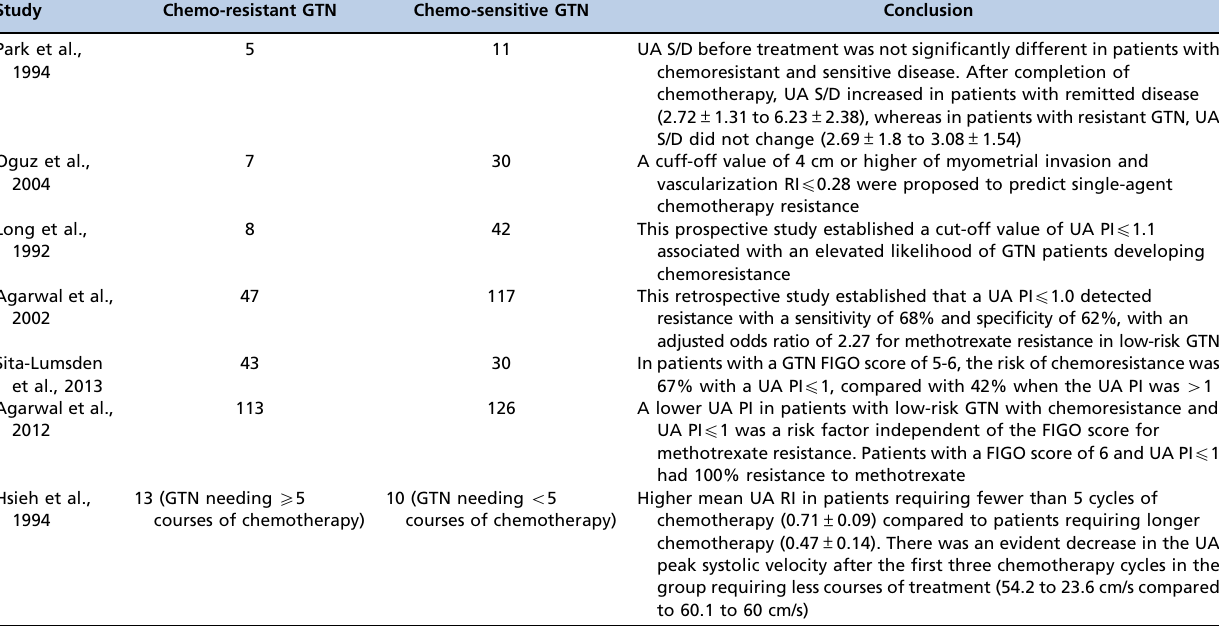
Table 3 - Studies that evaluated the role of Doppler ultrasound to predict chemotherapy resistance. GTN: gestational trophoblastic neoplasia; n: number of patients; UA S/D: uterine artery systolic/diastolic velocity; UA PI: uterine artery pulsatility index; UA RI: uterine artery resistance